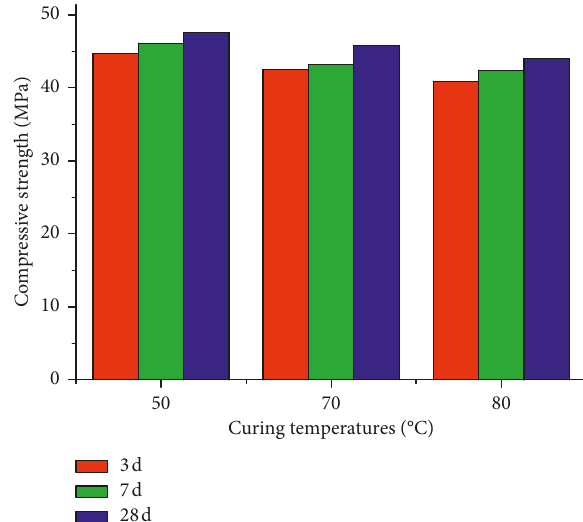
Figure 3: Compressive strength of CSA/GFRC cured at different curing regimes.